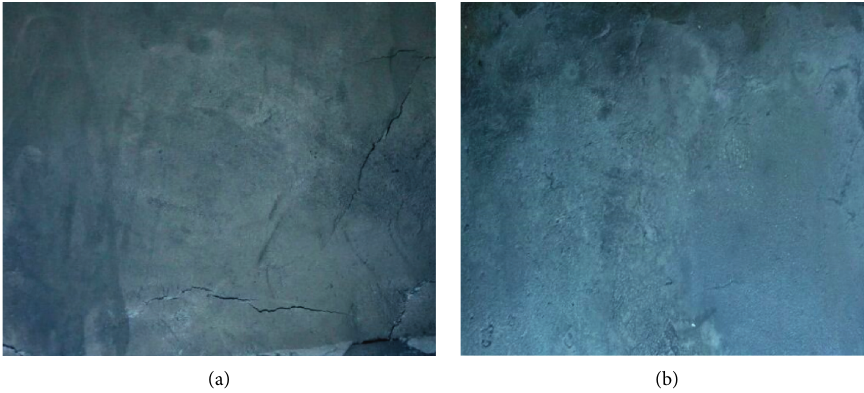
Figure 4: Surface of CGA mortars with and without PP fiber. (a) Without PP fiber. (b) 0.9% PP fiber.